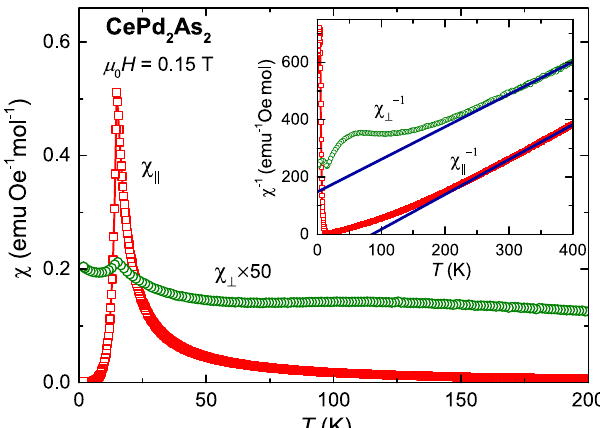
Figure 1. Temperature dependence of the magnetic susceptibility χ = M / H for magnetic fields applied parallel ( χ ) and perpendicular ( χ ⊥ ) to the c -axis. Here, M is the magnetisation and H is the magnetic field. The inset displays the inverse magnetic susceptibility as a function of temperature. The solid lines represent fits of a Curie- Weiss law, χ ( T ) = C /( T − θ W ), to χ T ( ) and χ ⊥ ( T ) in the temperature interval 300 K ≤ T ≤ 400 K and 350 K ≤ T ≤ 400 K , respectively.